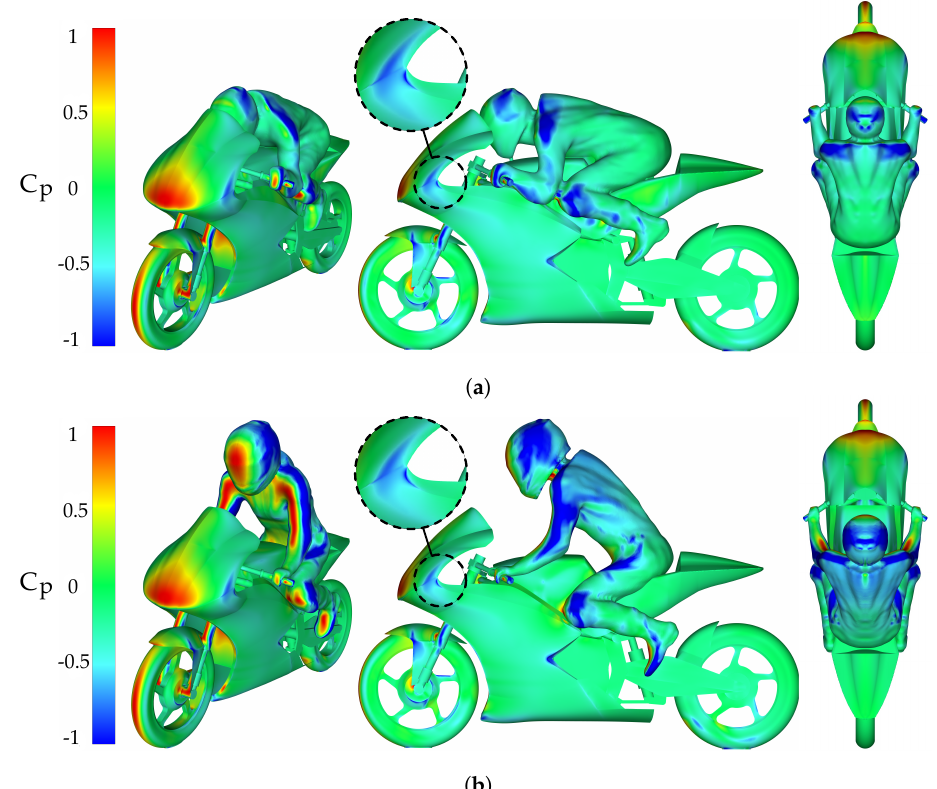
Figure 21. Contours of pressure coefficient for a rider in ( a ) low-drag position and ( b ) in an upright